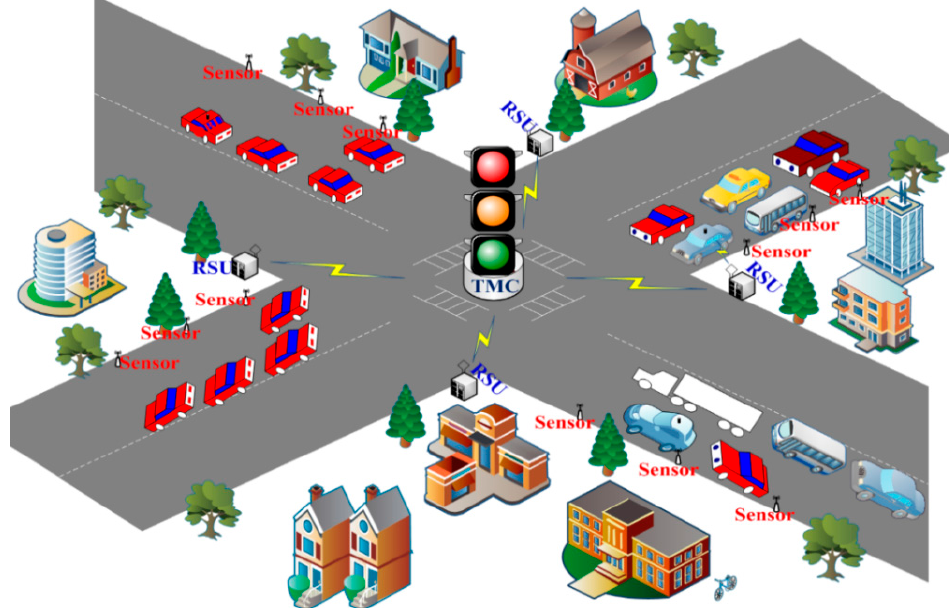
Figure 1. WSN-based Urban Traffic Management System.